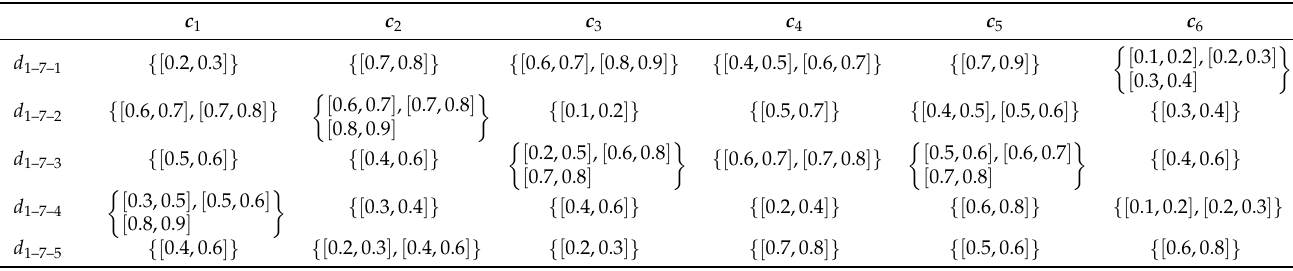
Table A7. Scoring matrix of listed company d 1–7 .